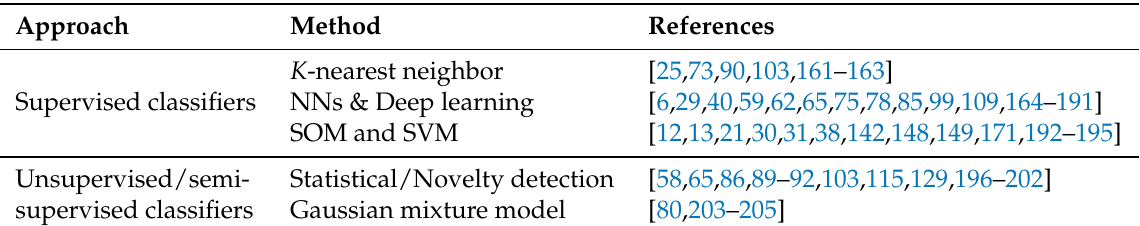
Table 3. The taxonomy and a supplementary list of references about supervised and unsupervised or semi-supervised classifiers used for defect